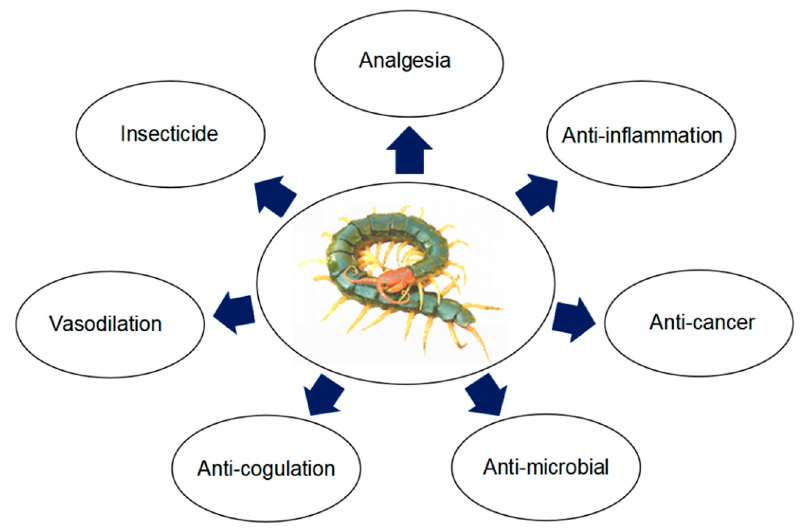
Figure 2. Functions of bioactive peptides and proteins from centipede.